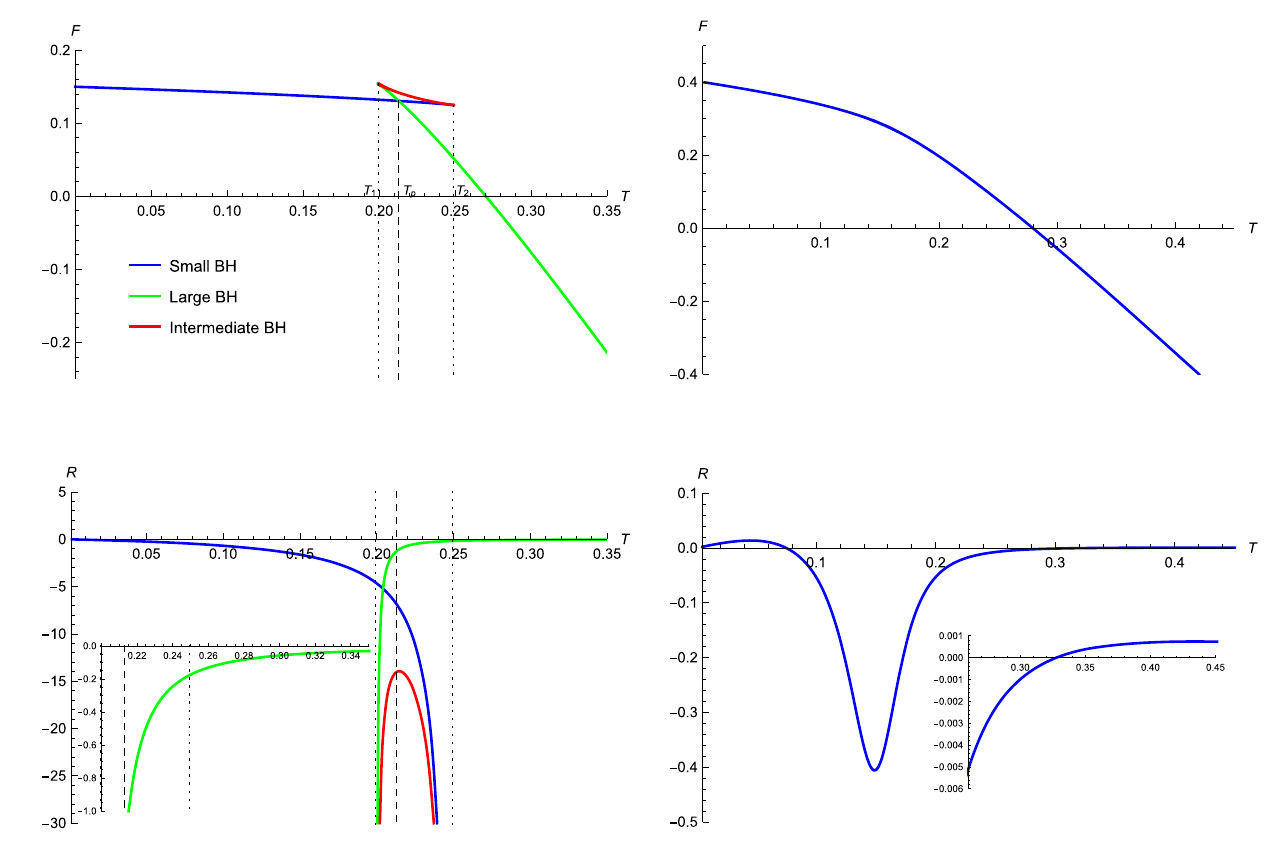
Fig. 6 The free energy F and the Ruppeiner invariant R as functions of the temperature T for a RN black hole in a cavity with a fixed charge Q . Left Column Q = 0 . 15 < Q c . Three black hole solutions coexist for T 1 < T < T 2 . A LBH/SBH first-order phase transition occurs at